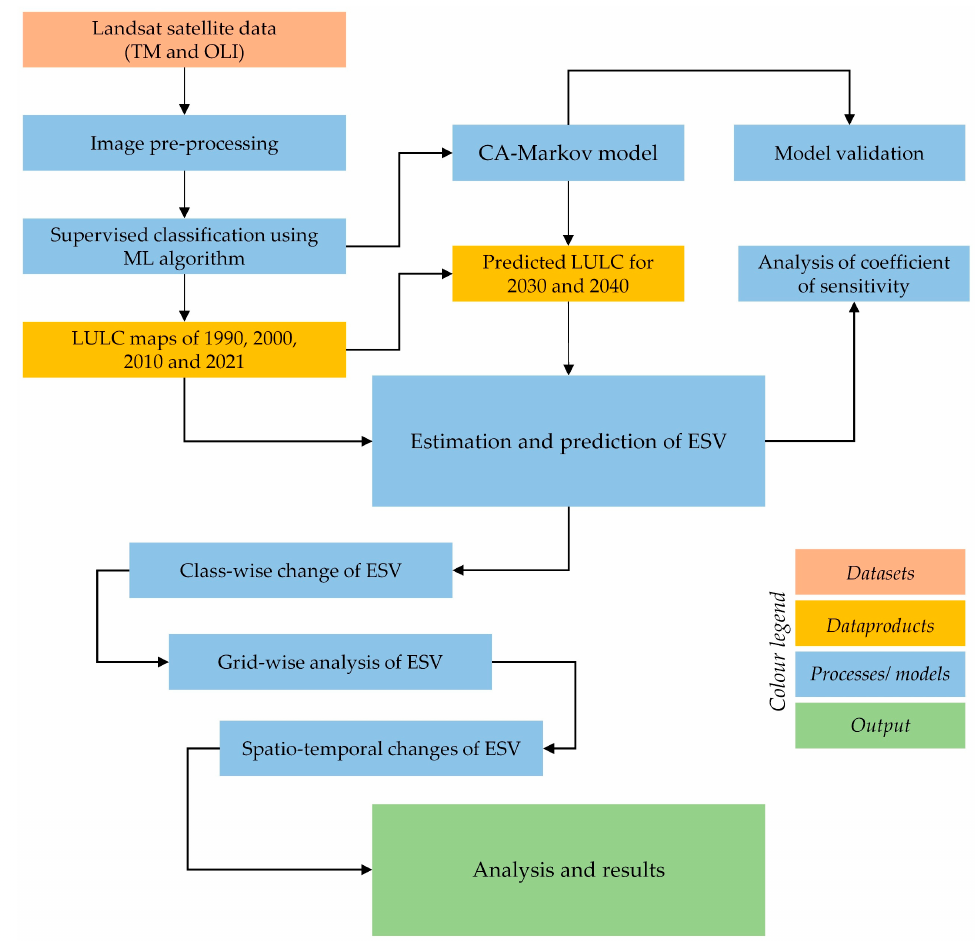
Figure 2. Methodology flowchart adopted in the study. Table 2. Description of ecosystem service coefficient as per Costanza et al. (1997,